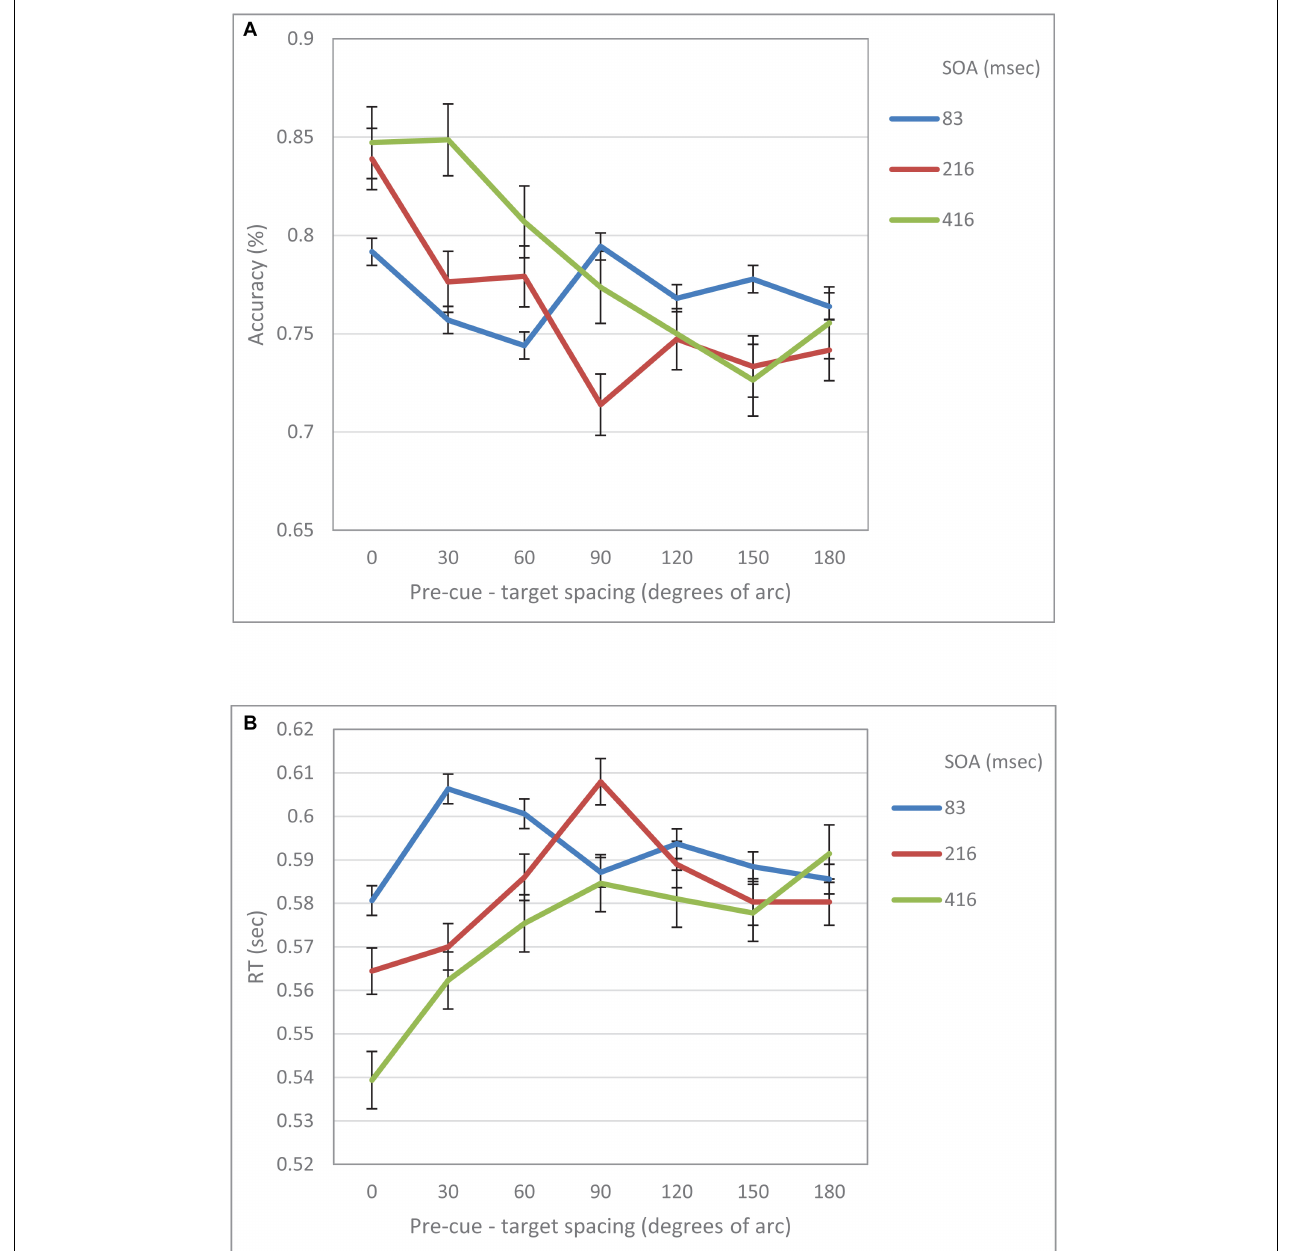
FIGURE 6 | (A) Accuracy in Experiment 2 as a function of pre-cue – target spacing and SOA. (B) RT in Experiment 2 as a function of pre-cue – target spacing and SOA.